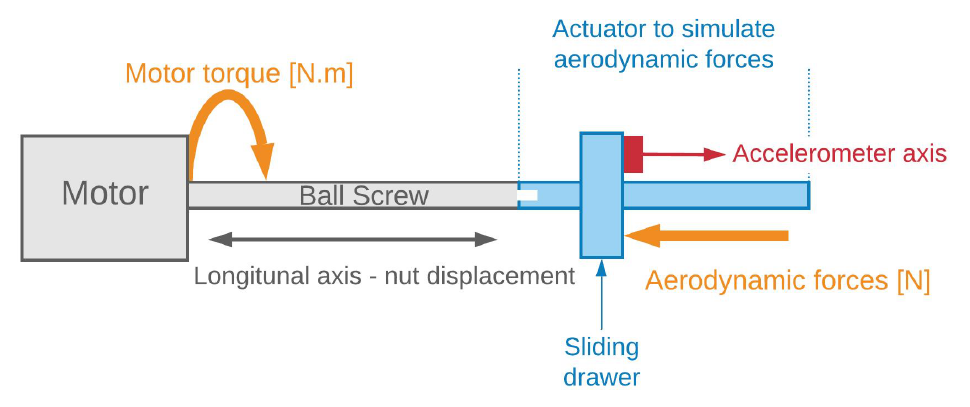
Figure 5. Schematics of the instrumented actuator bench.